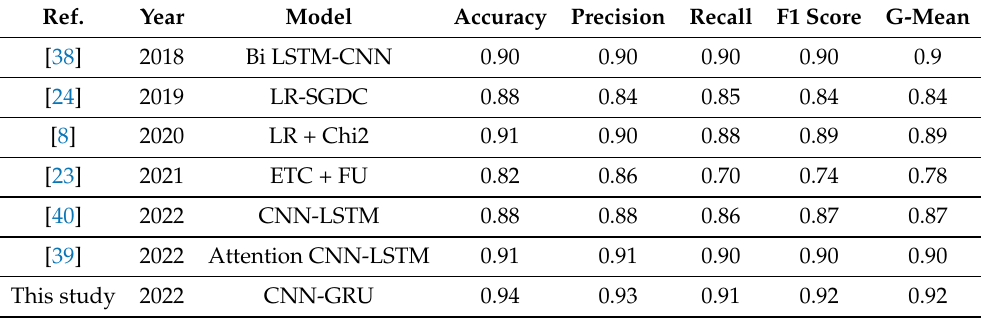
Table 19. Comparison with other approaches.